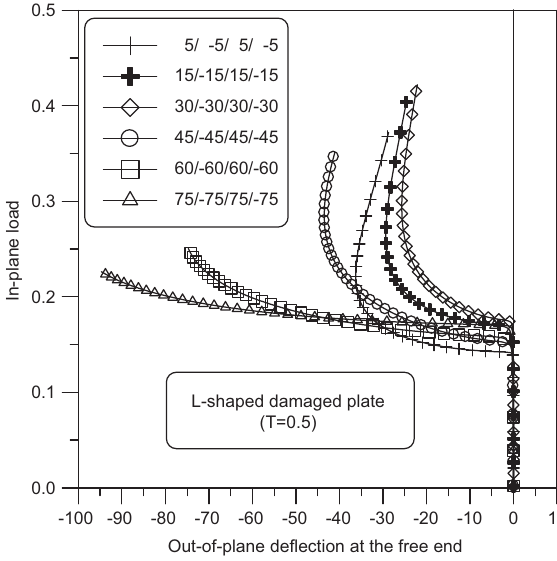
Figure 7 Tip defl ection at the free end of the L-shaped damaged plate.